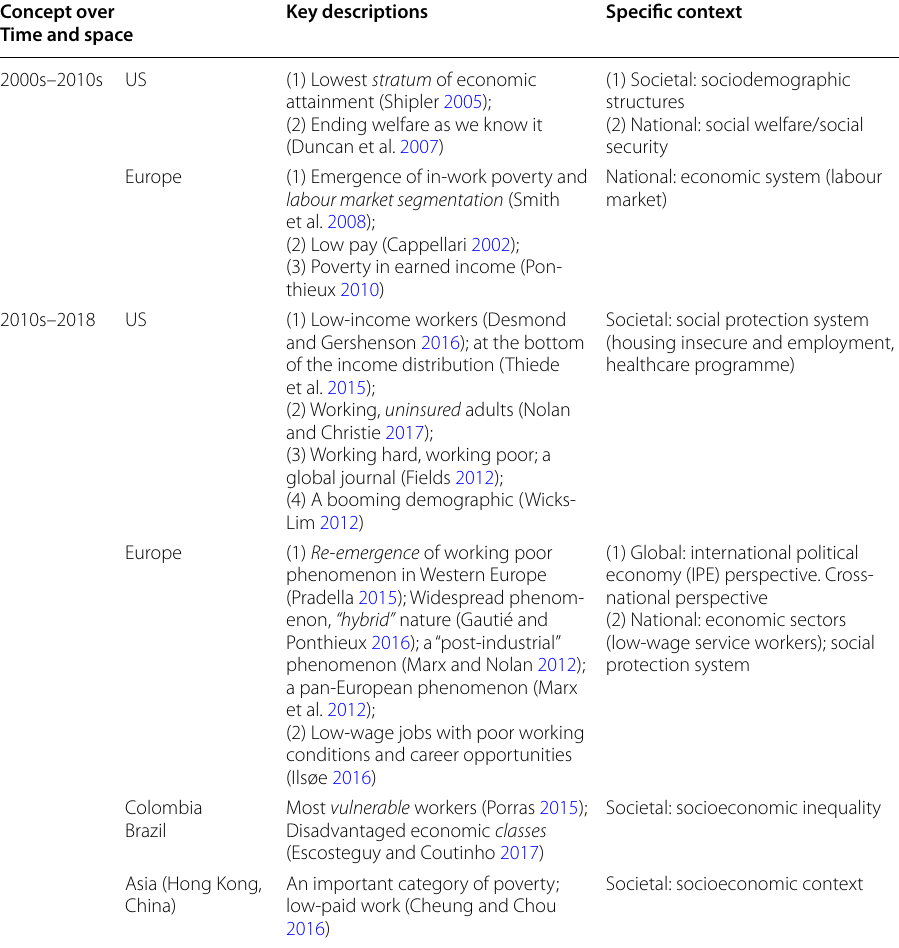
Table 3 Right words/Key terms in in-work poverty research (2000s-2017) Concept over Time and